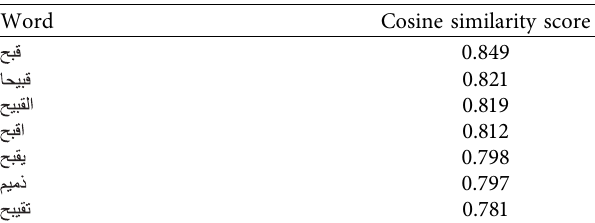
Figure 3: Number of words filtered by the collocation filter based on their evaluation. Table 1: The most similar words for “ /ugly” produced by Sketch Engine.